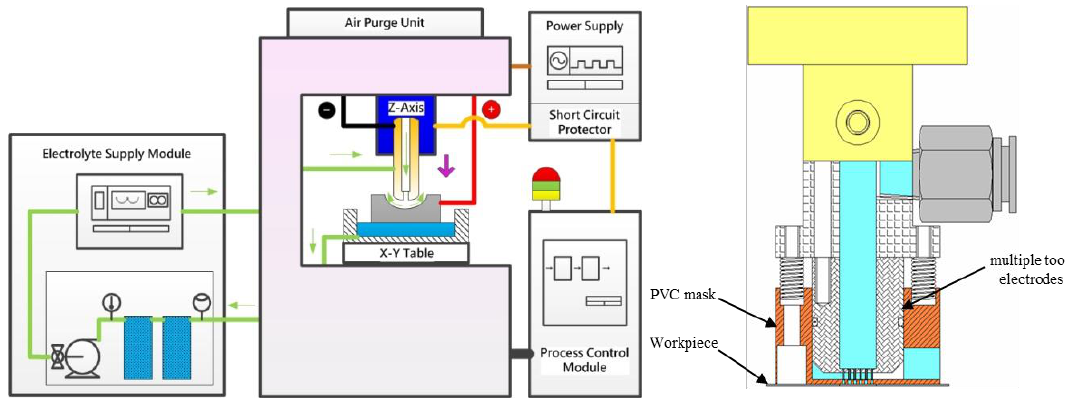
Figure 1. Schematic diagram of electrochemical micromachining system ( left ) and micro-array hole electrode module ( right ).